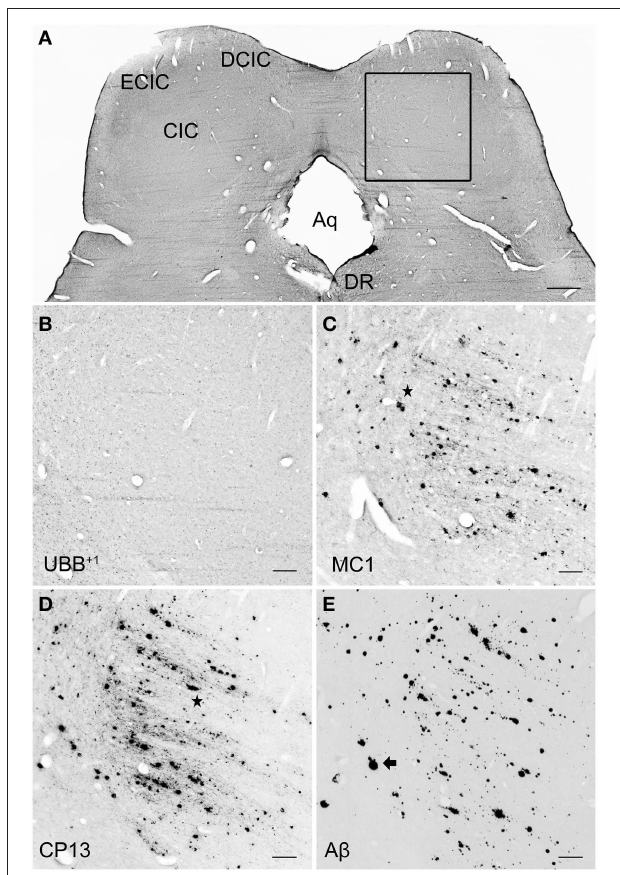
FIGURE 7 | UBB + 1 and AD neuropathology (NFTs, NTs, and A β plaques) in the human IC. (A) Representative photomicrograph of a 50 µ m-thick coronal section from the brainstem of patient #6 (Braak 5). (B–E) Higher magnifications of the boxed region in (A) incubated with four antibodies against (B) UBB + 1 , (C) pre-tangles material (MC1), (D) tangles (CP13), and (E) A β plaques. The IC show selective vulnerability to A β accumulation, expressing a high number of both neuritic (star) and non-neuritic (arrow) plaques. Neuronal staining, represented by NFTs and UBB + 1 -immunoreactive substrates, is not present in this region. Bars: (A) , 1mm, (B–I) , 200 µ m. Aq, cerebral aqueduct; CIC, central nucleus of IC; DCIC, dorsal cortex of IC; DR, dorsal raphe nucleus; ECIC, external cortex of IC; IC, inferior